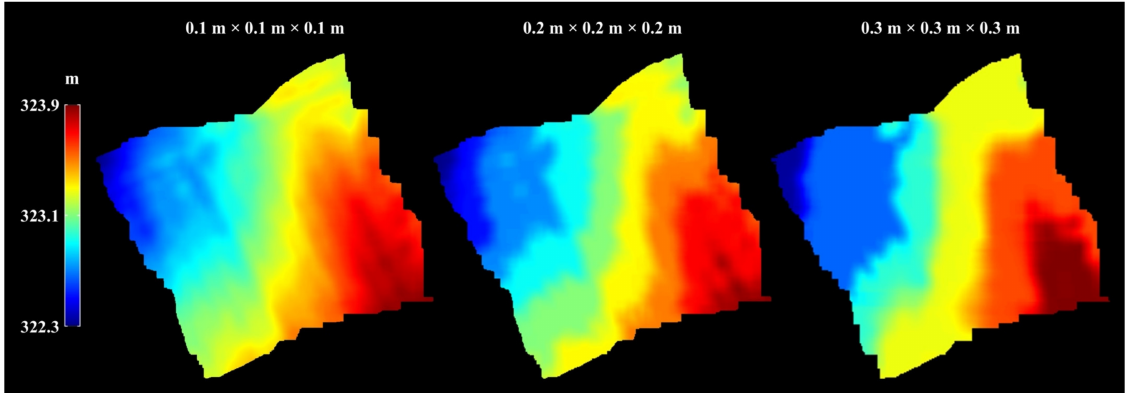
Figure A5. Example smoothed terrain maps of the sample orchard point cloud generated using different terrain grid filters. The maps were smoothed by a 3.3 m × 3.3 m averaging